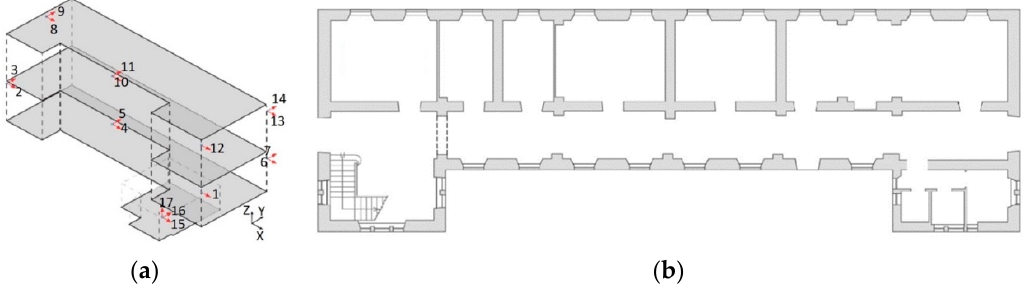
Figure 8. Building schematization: ( a ) floors schematization with sensors location; ( b ) plan.